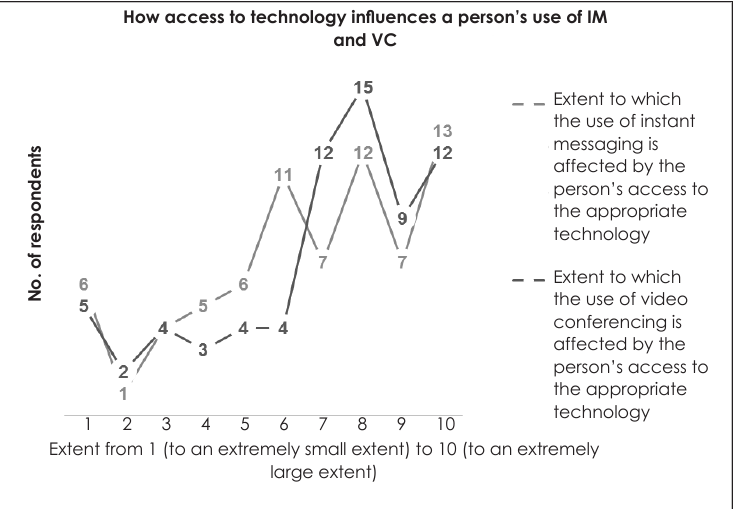
Figure 7: How access to technology determines a person’s use of CMC tools Of the respondents, 69% were of the opinion that access to IM technology such as the Internet, a computer and/or IM software does affect one’s use of IM as a communication medium. Similarly, 74% of the respondents are of opinion that access to VC technology such as the Internet, a webcam, a computer and/or VC software affect one’s use of VC as a communication tool. These findings correspond with Ferreira in Carvalho (2008), in that technology can cause physical communication barriers to information transmission. It is also important to note that technology can significantly contribute to the breakdown of communication in a project if all aspects of its use are not taken into consideration when writing the communications plan (Carvalho, 2008; Daim et al ., 2012). The seventh research question investigated whether IM and VC communication has an effect on the quality of communication if the team is geographically dispersed. As part of this question, the survey participants were also asked to what extent IM and VC communication leads to more appropriate (increased amount) project communication (see Figure 8 for